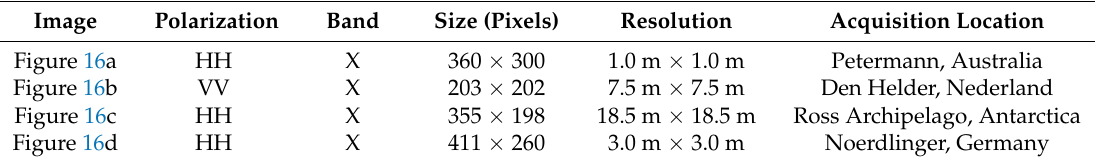
Table 1. Parameters for real-SAR images in Figure 16, where HH and VV denote the polarization models for horizontal transmit and horizontal receive and vertical transmit and vertical receive, respectively.